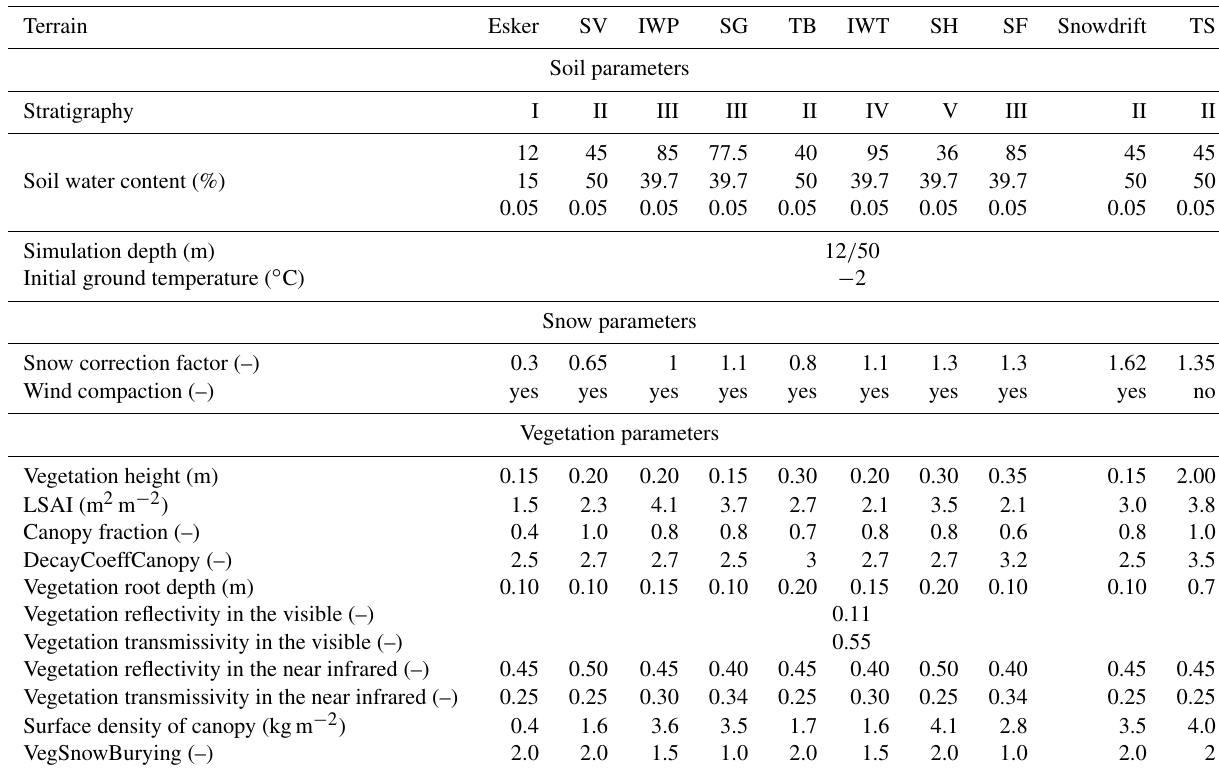
Soil parameters